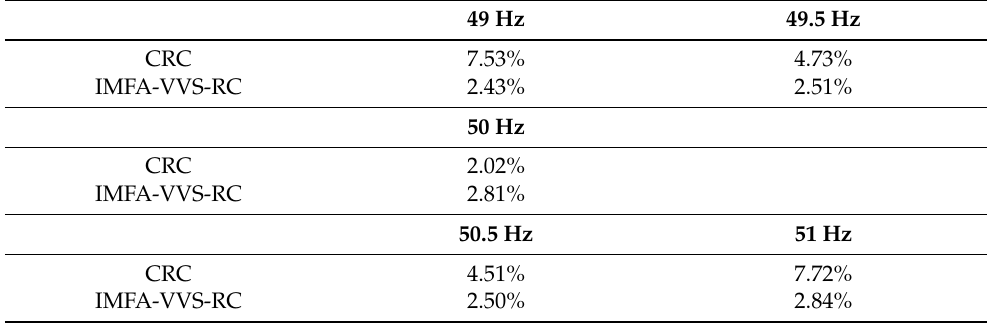
Table 2. The THD of the grid current i g .